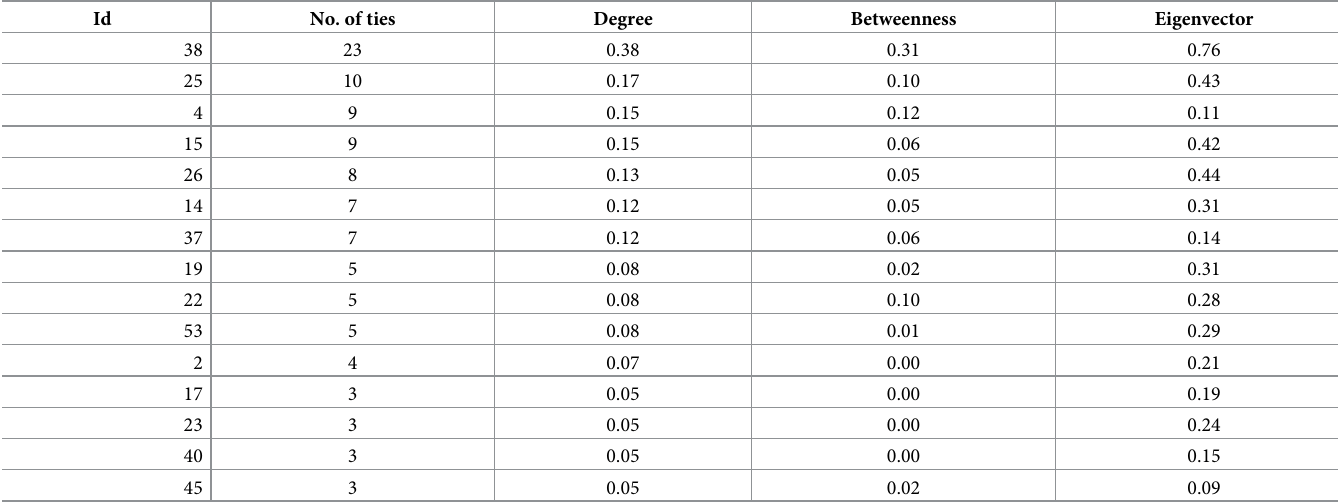
Table 2. Number of ties and normalized degree, betweenness, and eigenvector centrality scores of the 15 highest scoring organizations.